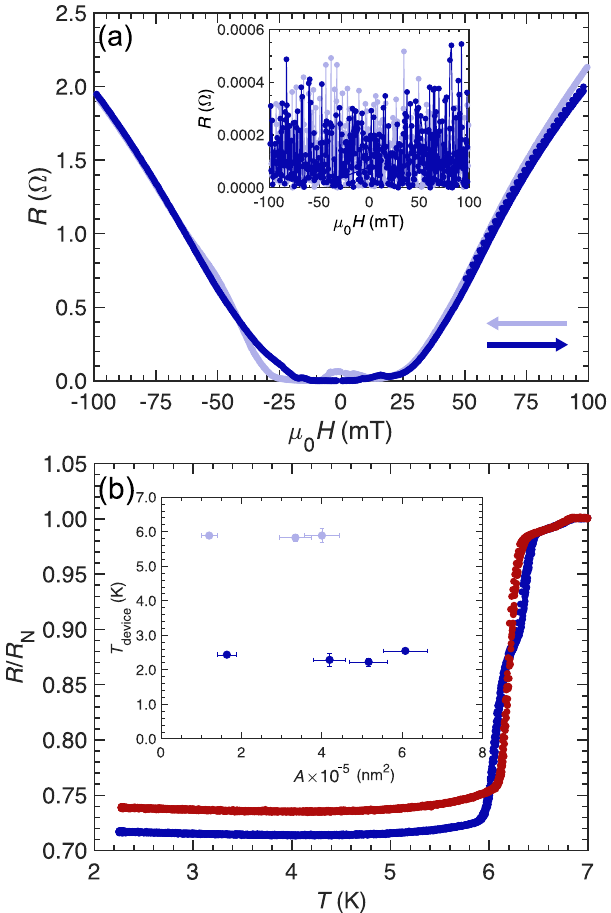
Fig. 6 Contact lead magnetoresistance and transition variation. a Major resistance ( R ) vs. in-plane magnetic fi eld ( H ) loop measured on the contact leads at 0.3 K for the device with Nb thickness d Nb = 21 nm ( μ 0 is the magnetic permeability in a vacuum). For this device only, there is a negative (parallel state is higher resistance) magnetoresistance response in the contact leads at the measurement temperature. Inset: for all other devices, the leads are superconducting below the contact lead transition, and show no magnetoresistance response at T / T device = 0.3, where T is temperature and T device is the onset temperature of the device transition. b R ( T ) curves from two devices on the same substrate d Nb = 57 nm, normalised by their normal state resistance for comparison. The difference between the temperature of contact and device transitions varies in an unknown manner, and can be small enough that the two transitions are indistinguishable. Inset: T device vs. nanopillar area, for a device showing the superconducting spin valve effect ( d Nb = 25 nm, dark blue) and a device showing quasiparticle giant magnetoresistance ( d Nb = 37 nm, light blue). Error bars represent measurement